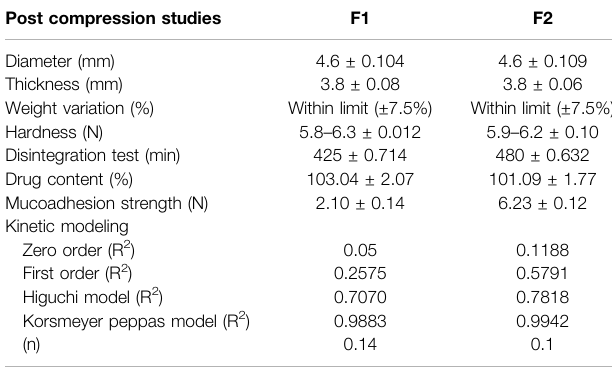
TABLE 6 | Post Compression studies of Formulations (F1,